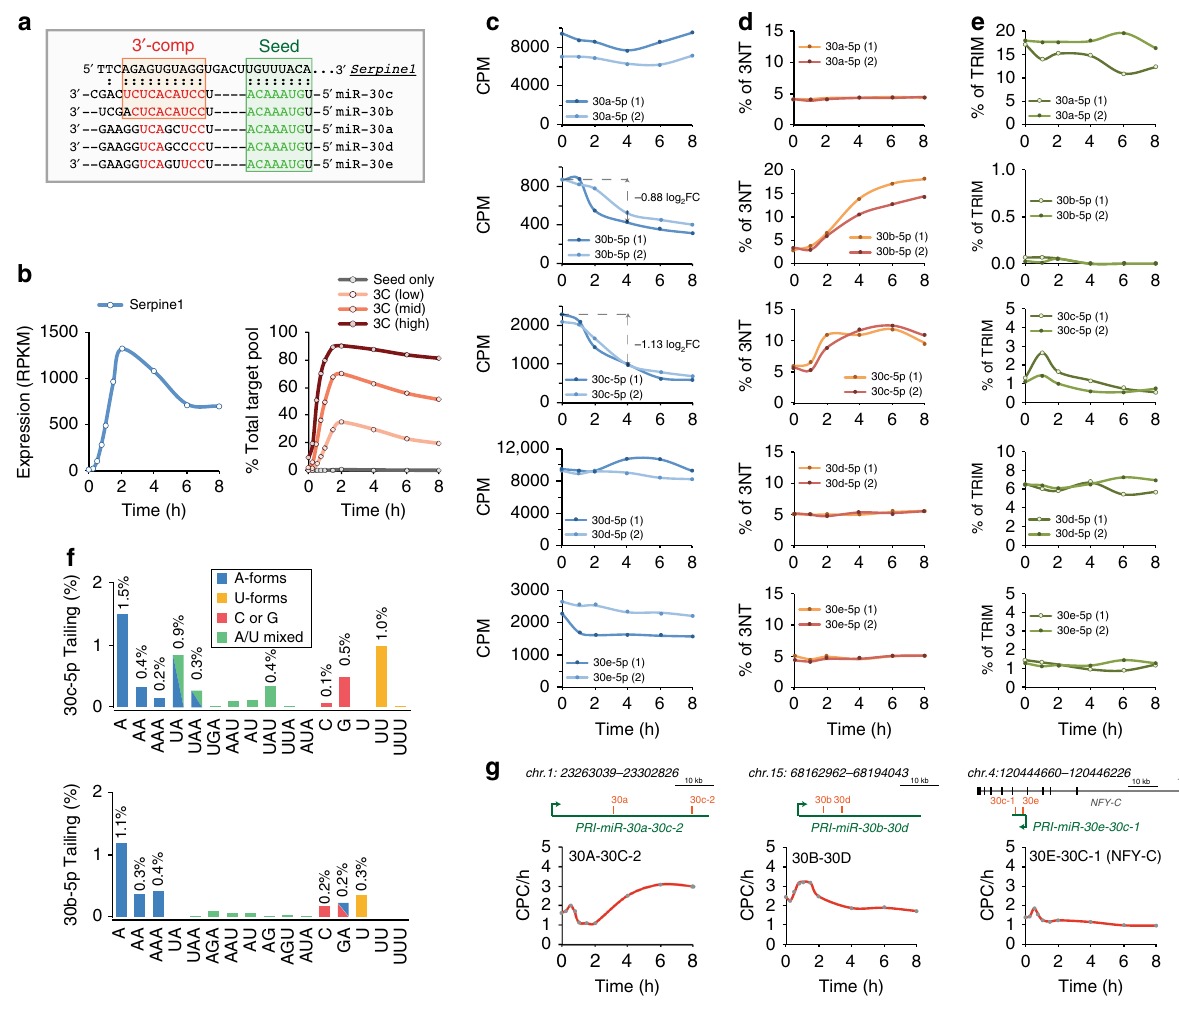
Fig. 2 Regulation of Serpine1 and miR-30 family members during serum stimulation. a Alignment of Serpine1-MRE with miR-30 family members. The seed- match (identical for all miR-30 family members) is shown in green, and the bases of 3 ′ complementarity, which is extensive only for two miRNAs (miR- 30b, 9 nt; and miR-30c, 11 nt), in red. b Expression of Serpine1 upon serum stimulation of quiescent 3T9 fi broblasts. Left panel, RPKM. Right panel, contribution of Serpine1 expression to the total target pool, calculated over different classes of 3C-score. c – e Expression of miR-30 family members upon serum stimulation of quiescent 3T9 fi broblasts. Shown for each miRNA are: c the expression level (counts per million, CPM), d tailing events (% of 3 ′ -non- templated isomiRs, 3NT) and e trimming events (% of trimmed forms, TRIM) in two independent experiments. f Frequency of tailing (3 ′ NT isomiRs) for miR-30c-5p (top panel) or miR-30b-5p (bottom panel) in asynchronously growing 3T9 cells. Percentages of total reads. g Synthesis rate of the primary transcripts of the miR-30 family upon serum stimulation, as measured by a short pulse of 4SU. De fi nition of genomic regions and calculation of synthesis rate as copies per cell per hour (CPC/h) have been described previously